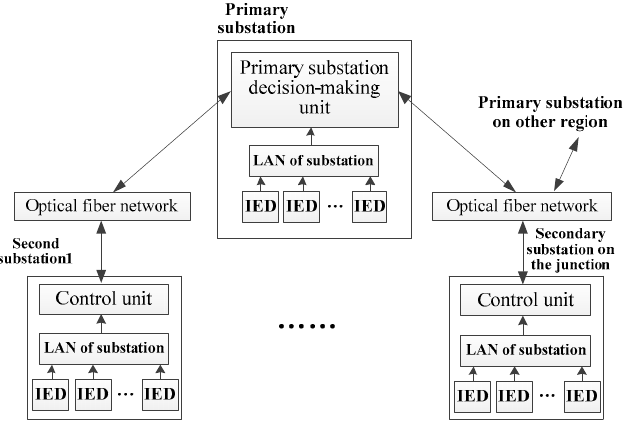
Figure 1. A communication system schematic of regional protection and the implementation of regional protection information transmission.